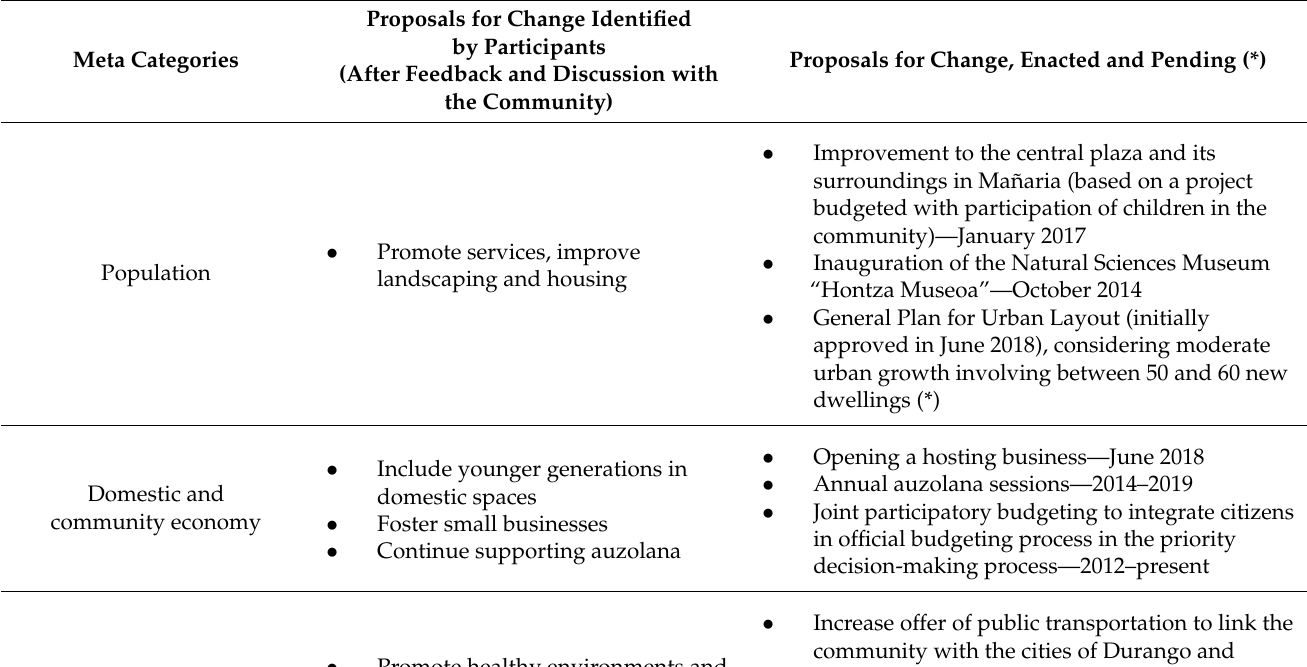
Table 4. Proposals or solutions identified by the study, including those enacted and those still pending.